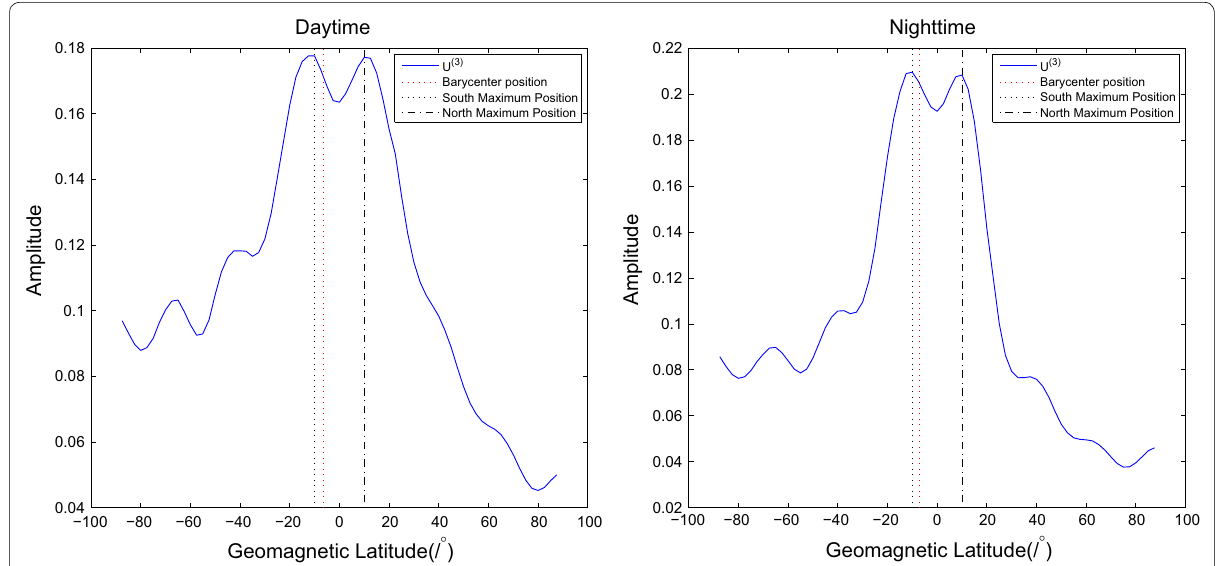
Fig. 7 The diurnal variations in NSA indicated by U ( 3 ) . The red, black dotted, and black dotted dash lines indicate the positions of the barycenters, and south and north maxima of U ( 3 ) , respectively. The x-axis is the latitude ranging from − 87.5 ◦ to 87.5 ◦ . a Results for daytime. b Results for